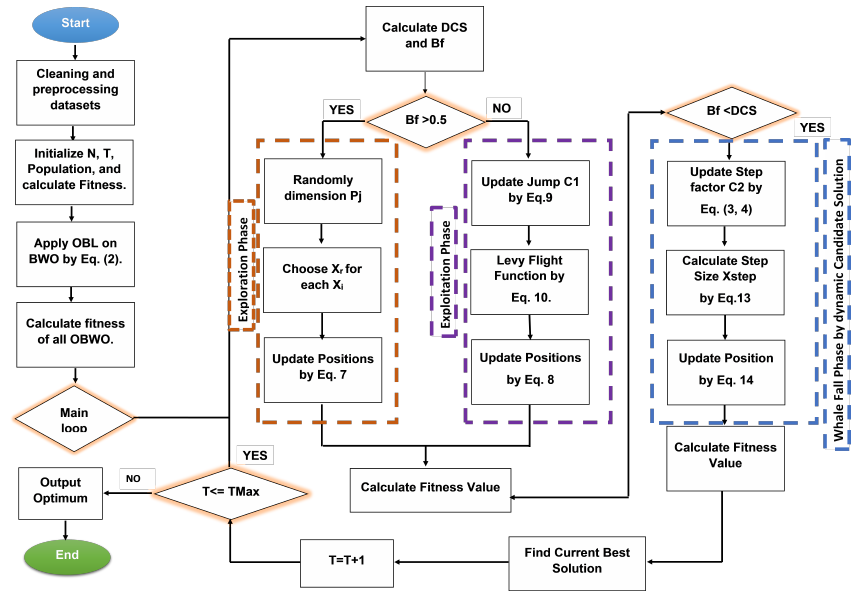
Figure 1. Flowchart of proposed OBWOD algorithm.